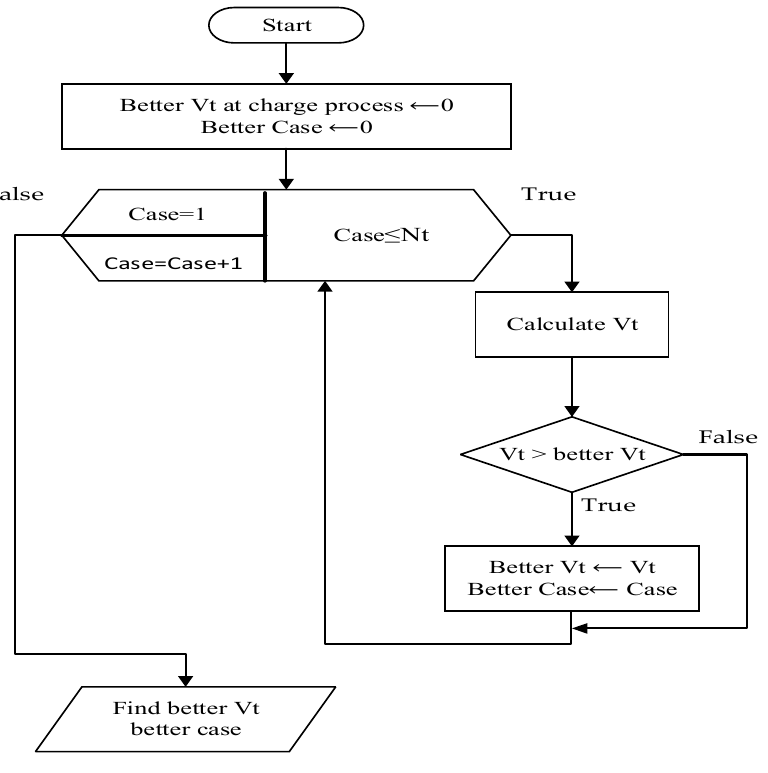
Figure 10 . Process flow chart . Figure 10. Process flow chart.